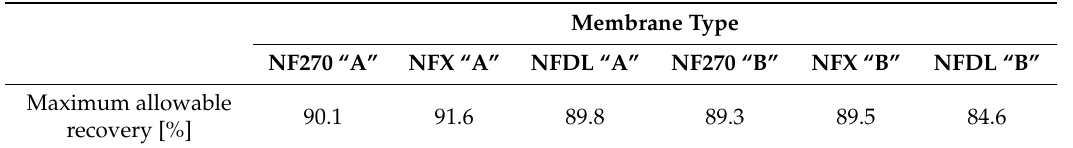
Table 4. The maximum allowable recovery for each membrane type and feed water (“A”: 0.384 g / L as Cl − , 1.02 g / L as SO 42 − , 0.107 g / L as Na + , 0.142 g / L as Mg 2 + , 0.312 g / L as Ca 2 + ; “B”: 33.2 g / L as Cl − , 0.937 g / L as SO 42 − , 19.5 g / L as Na + , 0.990 g / L as Mg 2 + , 0.771 g / L as Ca 2 +